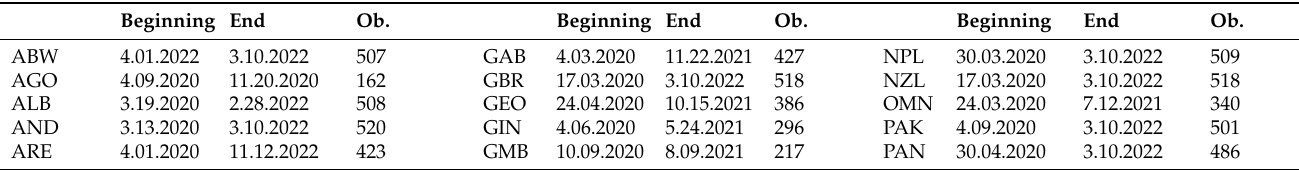
Table A1. Beginning and ending dates of sample data for